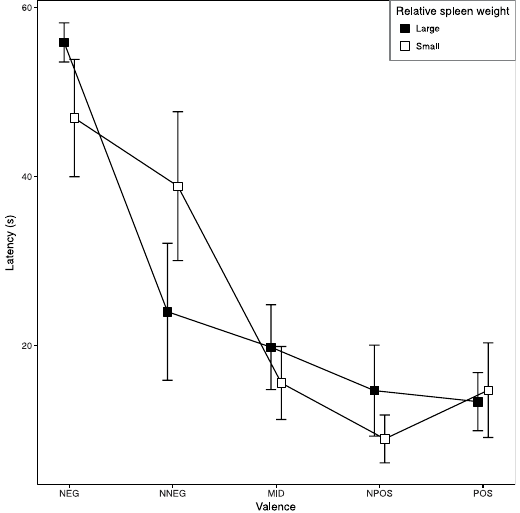
Figure 4. Birds with relatively smaller spleens are more pessimistic in trials in which the cone was placed at the near-negative location (NNEG). Line graph showing the mean ± 1 SEM latencies of the birds in two relative spleen size groups to approach the cone at each of the five locations in the judgment bias test. The two spleen size groups were obtained via a median split of the data; note that this is for visualisation purposes only, and the statistical model reported in the text modelled relative spleen size as a continuous variable. The significant valence x relatively spleen size interaction (see text for details) occurs because the birds with relatively small spleens were slower to approach the NNEG